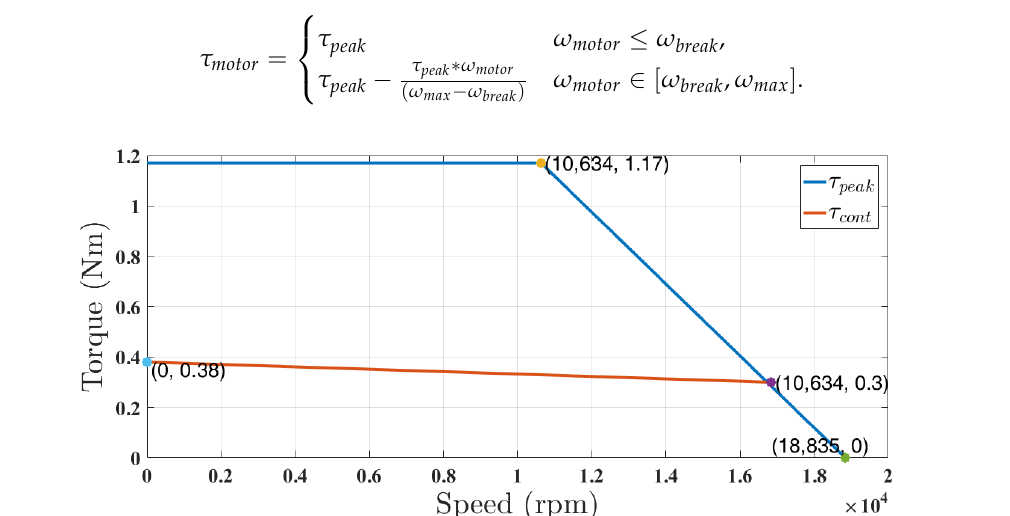
Figure 3. Torque speed curve of the motor K044100-6Y-4.98Ams when the voltage supplied to the motor is 120